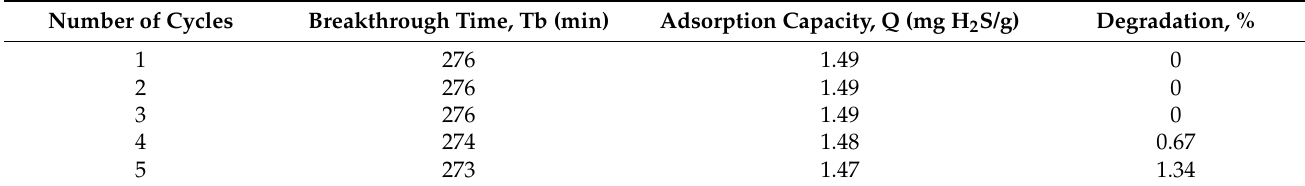
Table 4. Degradation of adsorption–desorption cycle.